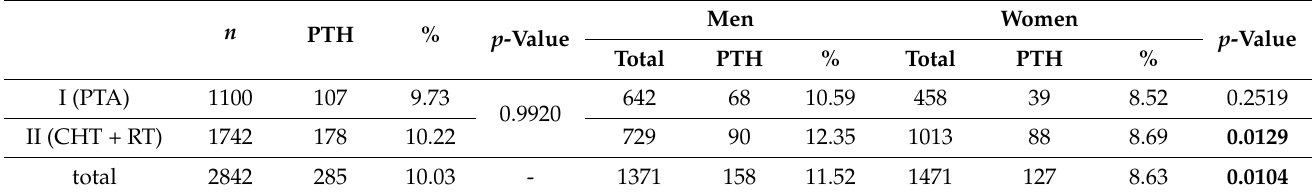
Table 3. Postoperative bleeding: men versus women.